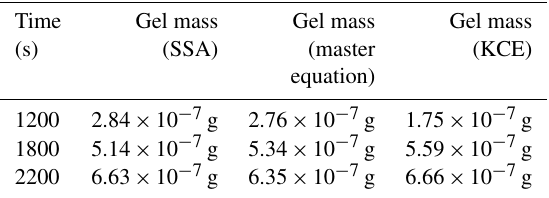
Table 1. Expected gel mass calculated from the SSA, the master equation and the kinetic approach. Simulations were performed for the product